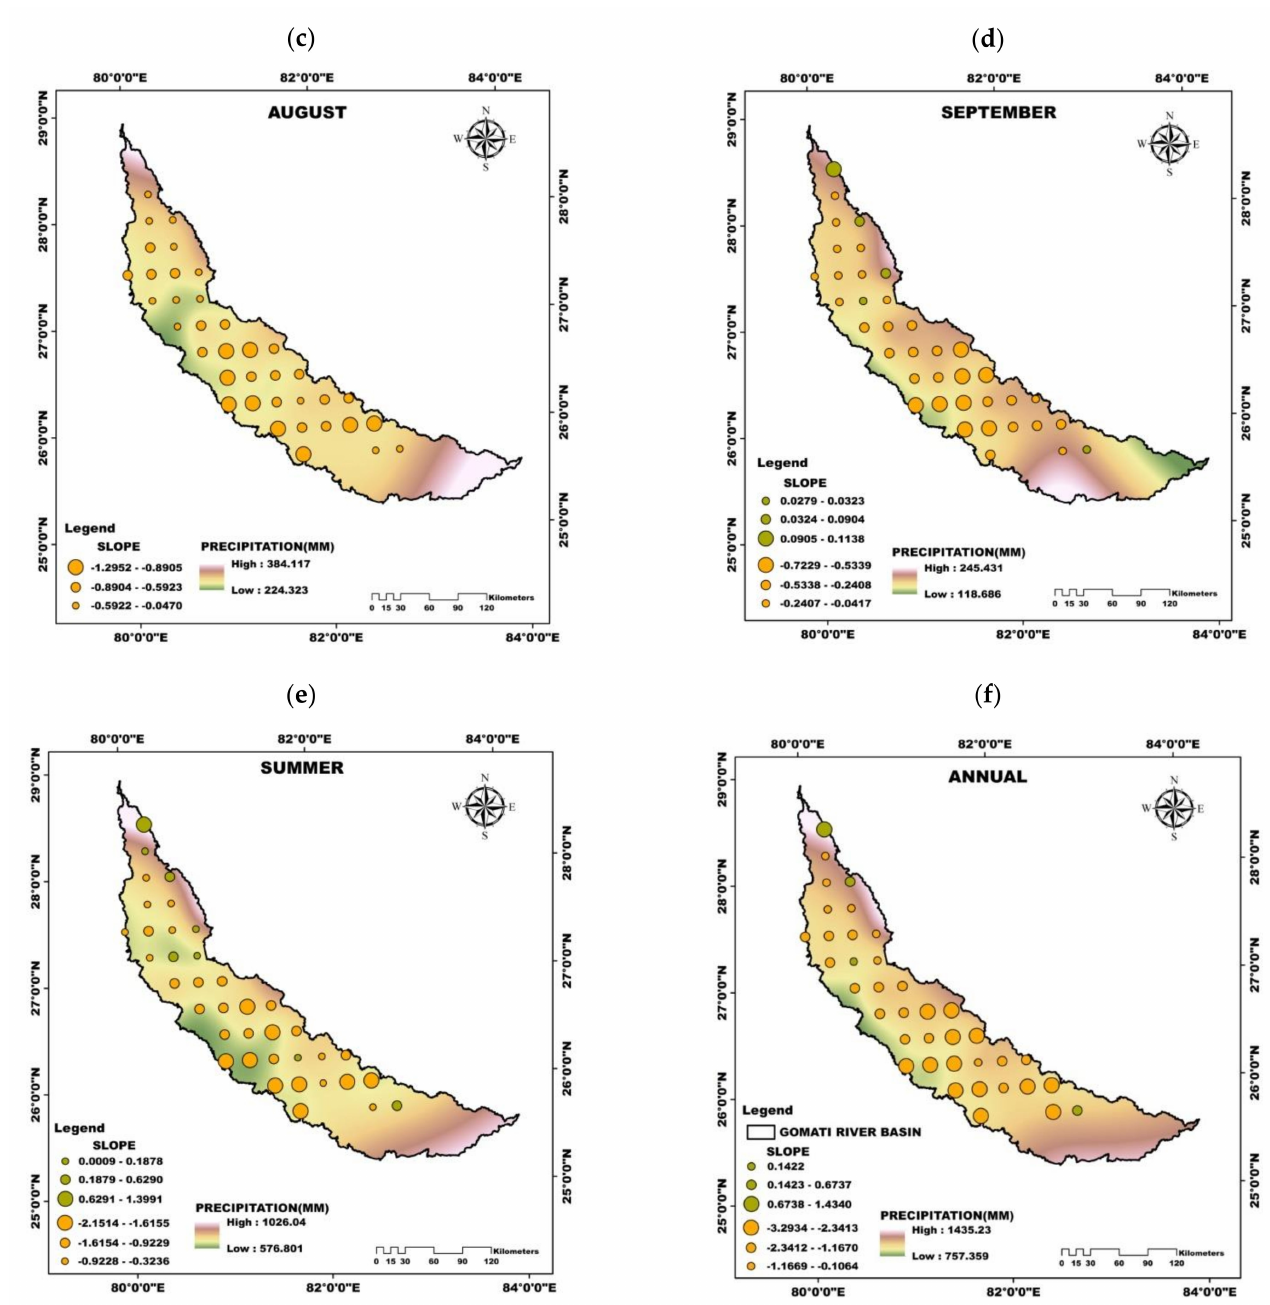
Figure 2. Spatio Temporal trends in the total precipitation at different time scales, ( a – d ) monthly, ( e ) seasonal, and ( f ) annual. The figure provides the Sen slope of the trend in each grid, which has significant